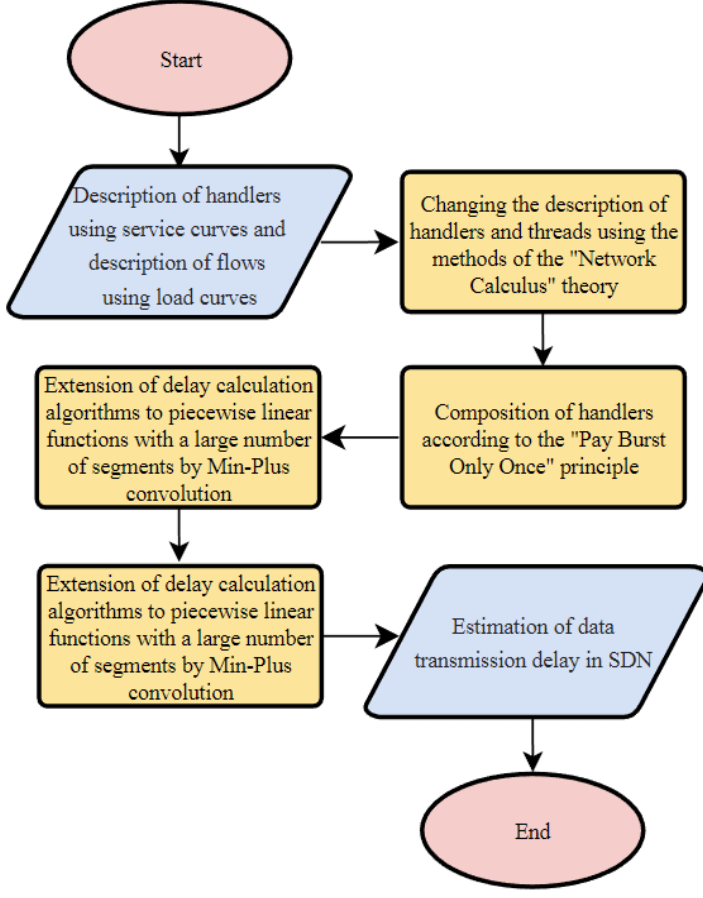
Figure 1. Schematic representation of the stages of data delay estimation in SDN using generalized algorithms based on network calculus theory and Min-Plus convolution